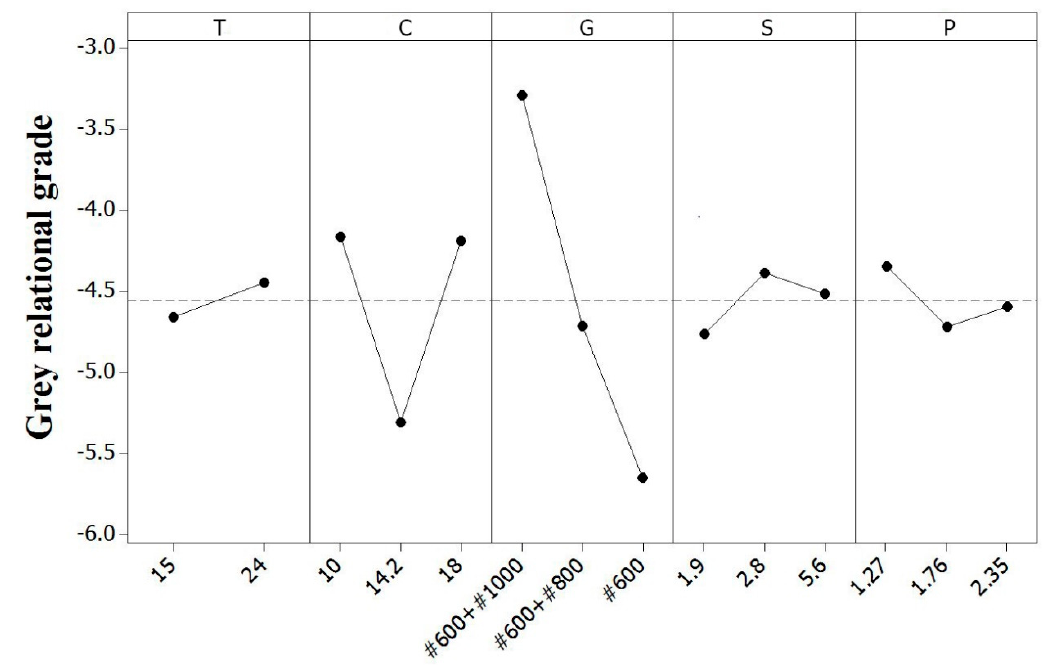
Figure 2. The S/N graph for the grey relational grade (GRG). Figure 2. The S / N graph for the grey relational grade (GRG). Table 8. Results of the confirmation test for multiple quality characteristics using the initial and the optimal process parameters.